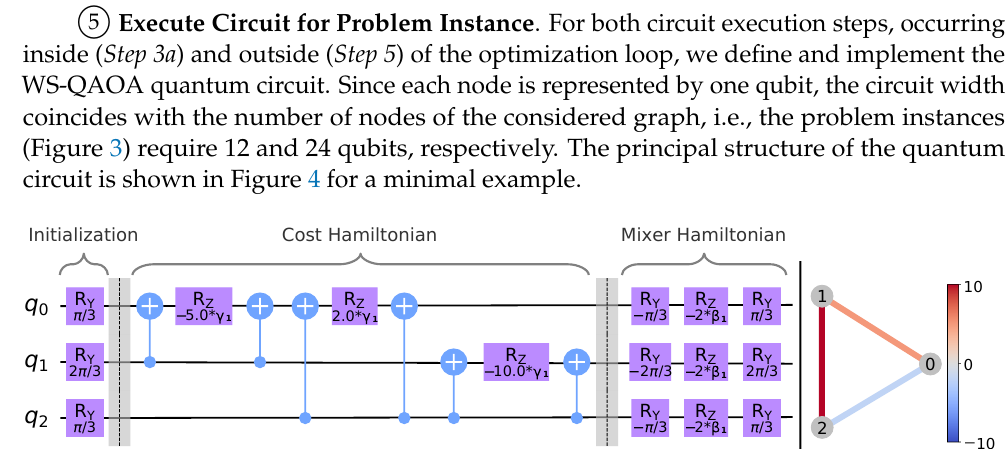
Figure 4. Minimal example: The quantum circuit on the left implements WS-QAOA with p = 1 for the 3-node graph depicted on the right-hand